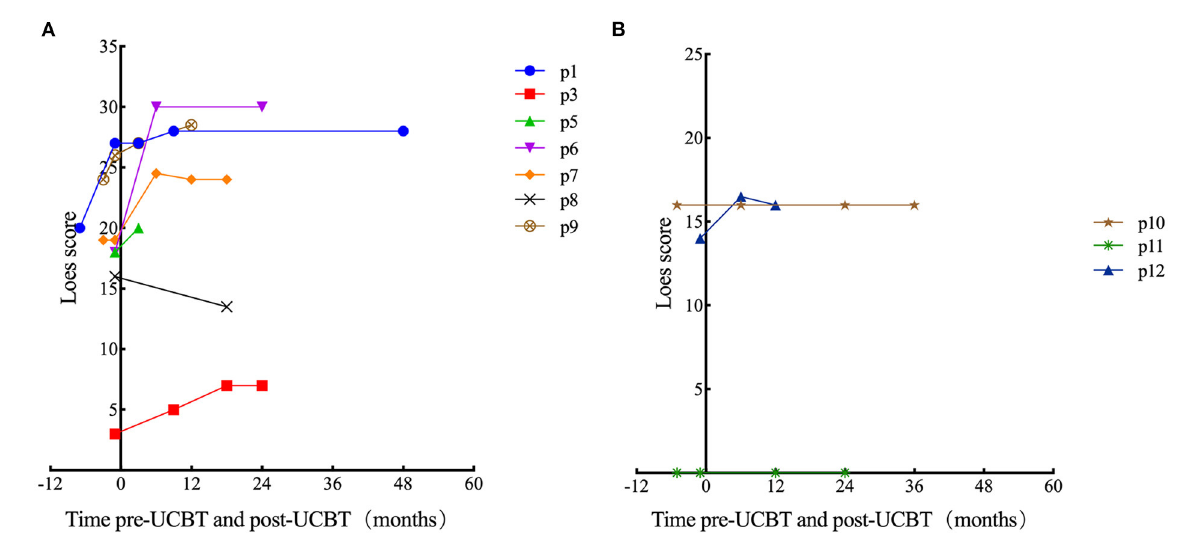
FIGURE2 Time course of Loes score changes for all patients. In some cases, there was no post-UCBT data because of early death (p2) or because the parent (of p4) refused MRI examination after transplantation. (A) Patients with ALD. (B) Patients with